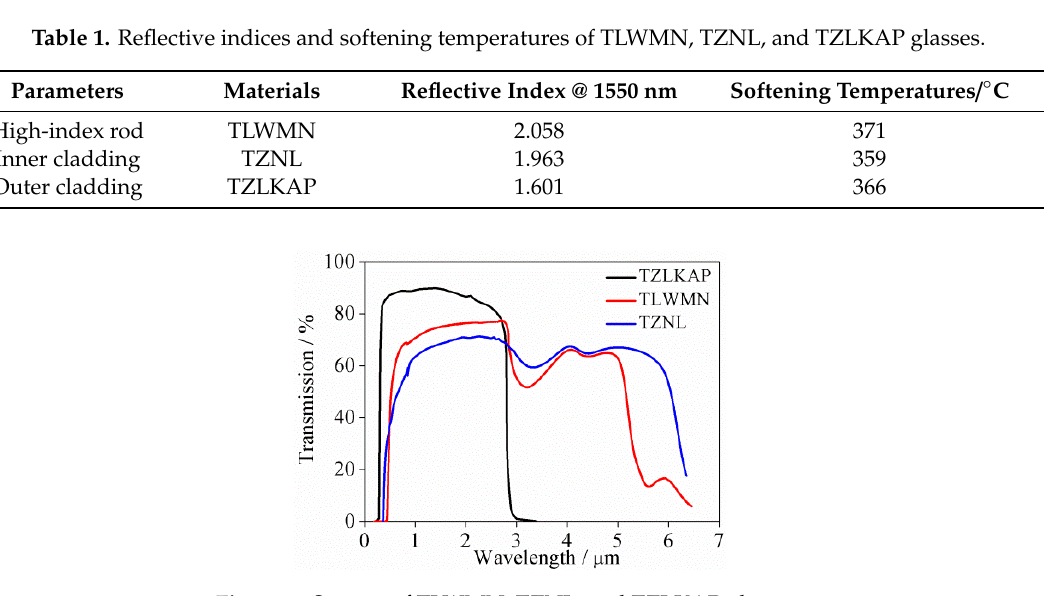
Figure 2. spectra of TLWMN, TZNL, and TZLKAP glasses. Figure 2. Spectra of TLWMN, TZNL, and TZLKAP